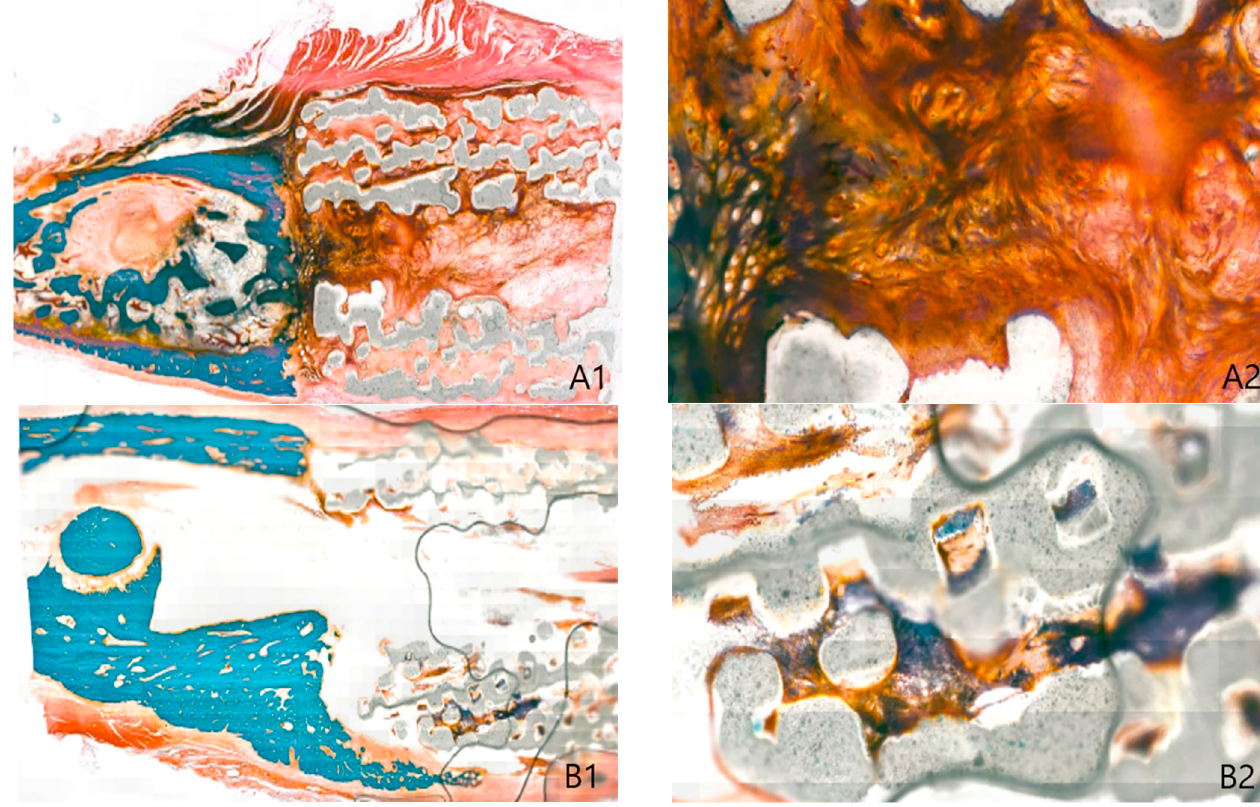
Figure 4. PTE + SA group: biopsy of adipose-derived stem cells with the 3D printing model of beagle 8 weeks postoperative day (Goldner trichrome stain). ( A ) Anterior marginal area, ( B ) posterior marginal area, (1. original magnification × 20, 2. original magni- fication ×100) .